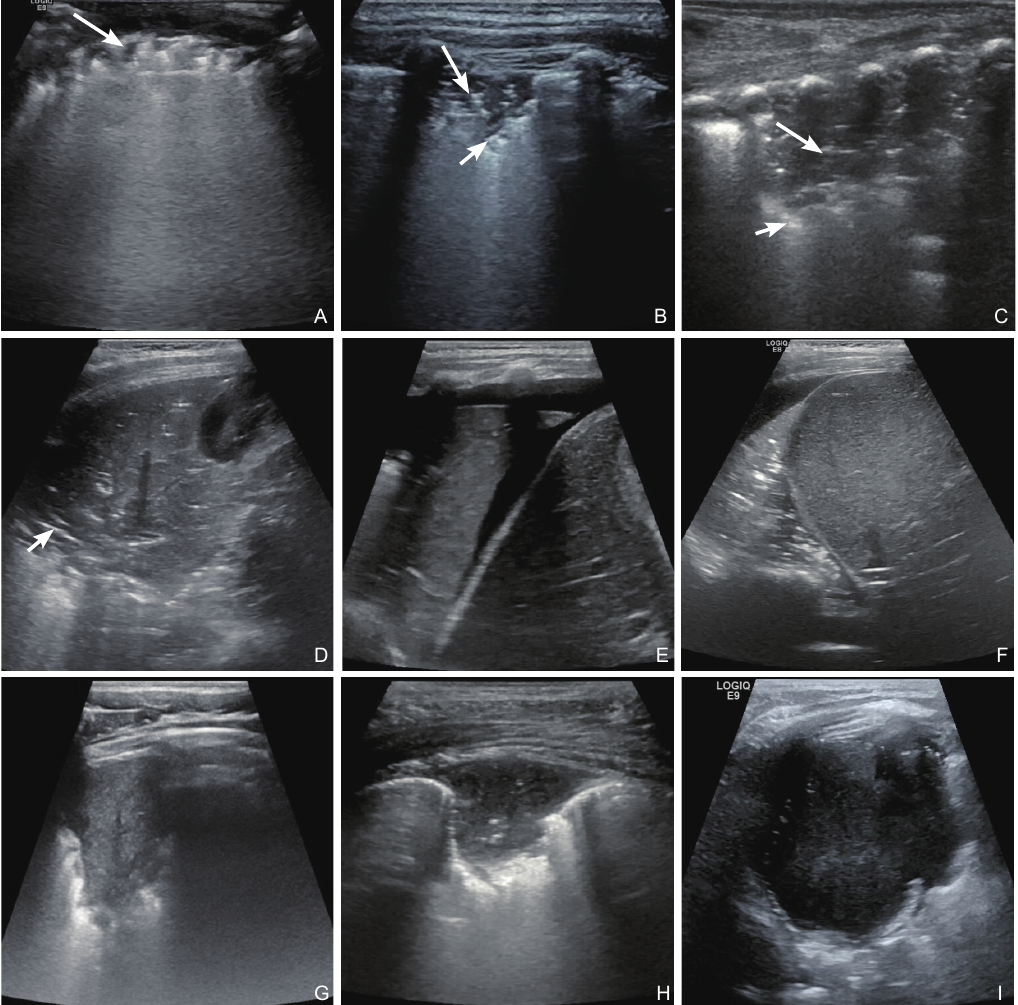
Figure 5 Lung consolidation sonograms. (A) Small fragment-like consolidation scattered under the pleural line (long arrow); (B ~ C) Pulmonary consolidation was accompanied by bronchial inflation echo (long arrow) and peripheral pulmonary B-line echo (short arrow); (D) Local atelectasis with pleural effusion; (E) Pulmonary consolidation after ECMO; (F) Pulmonary embolism showed wedge-shaped consolidation; (G) Necrotizing granuloma of lung; (H) Consolidation of lung with fluid bronchogram (arrow); (I) Pleuropulmonary blastoma.